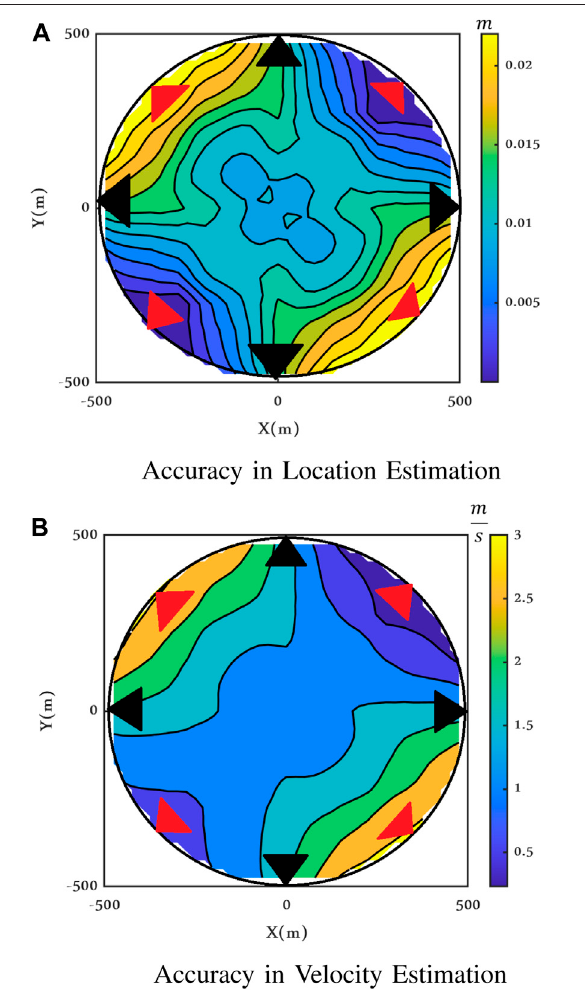
FIGURE 22 | Maximum achievable accuracy for shifted receiver antennas when the target is moving, Clutter Model I, ] = 2.1 and SCR = − 15 dB.